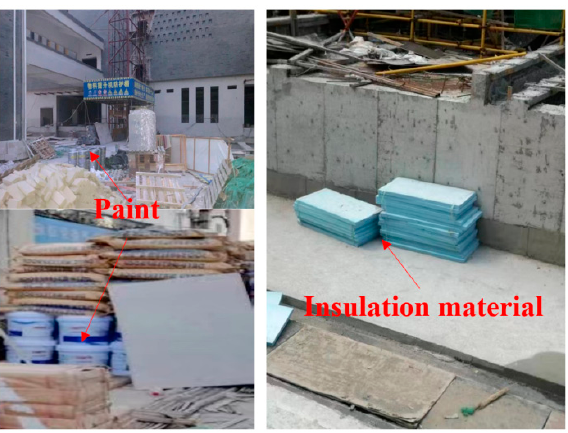
Figure 11. The storage places of paint and thermal insulation materials.